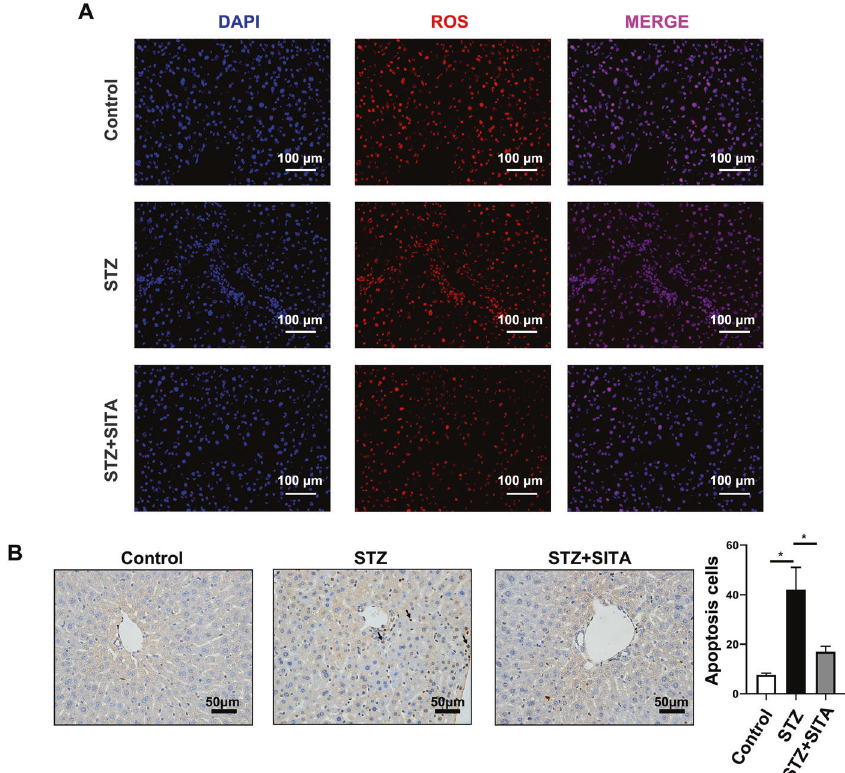
Fig. 5 Sitagliptin prevents cell apoptosis in diabetic mice. A , B TUNEL and ROS staining of liver tissue (scale bar 100 and 50 μ m).